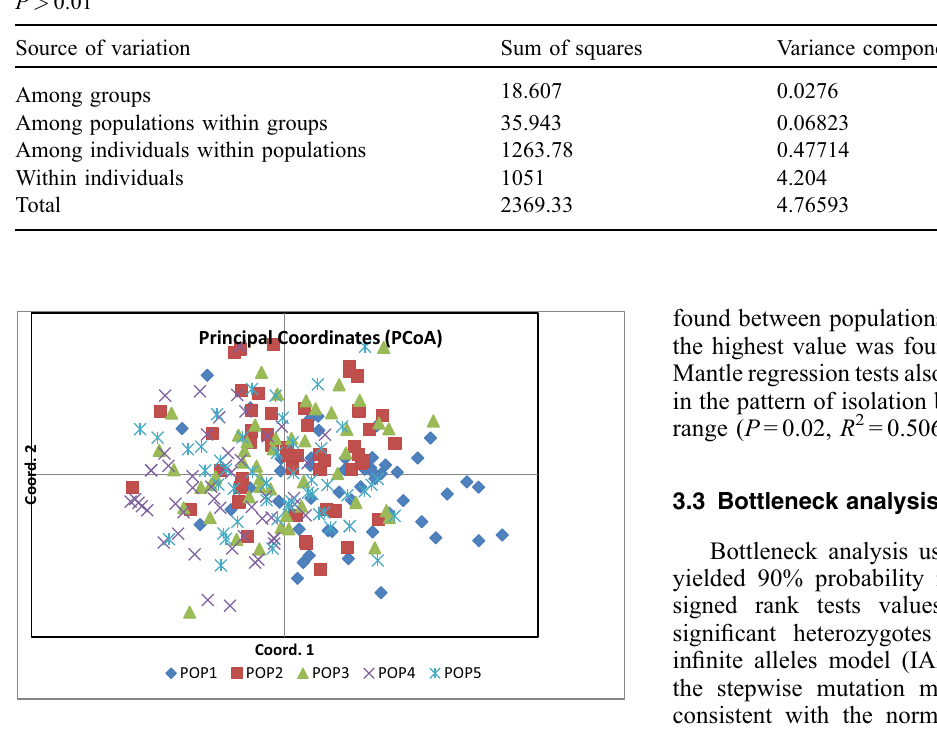
Fig. 3. Two-dimensional plot of the Principal Coordinates Analysis (PCoA) of S. commerson performed using